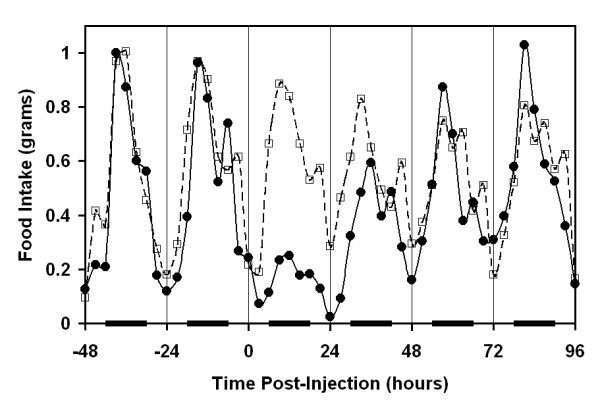
Circadian pattern of food intake and effect of endotoxin administration. Food intake was monitored continuously. Endotoxin (0.1 mg/kg, solid line) or carrier (dashed line) was administered IP at time 0. Black bars along the abscissa indicate scotophase. Data points represent mean measurements of six mice in 3 hour time bins.